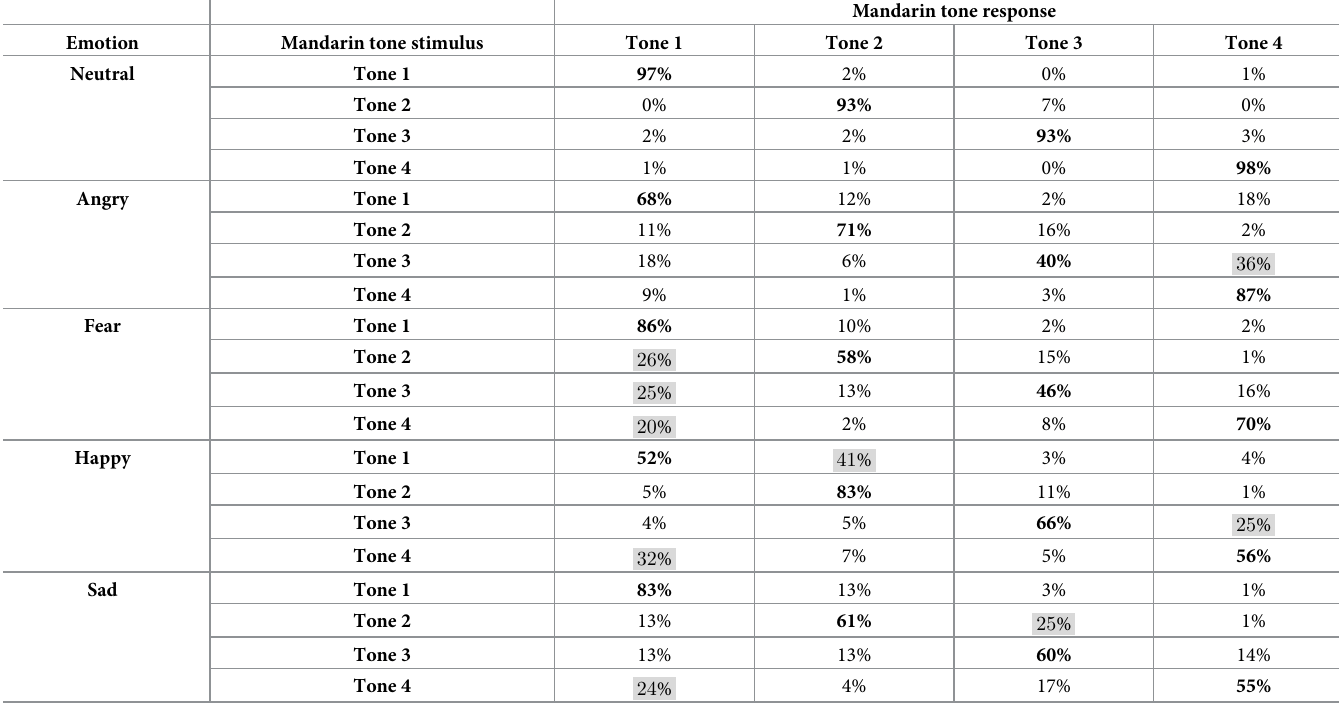
Mandarin tone response